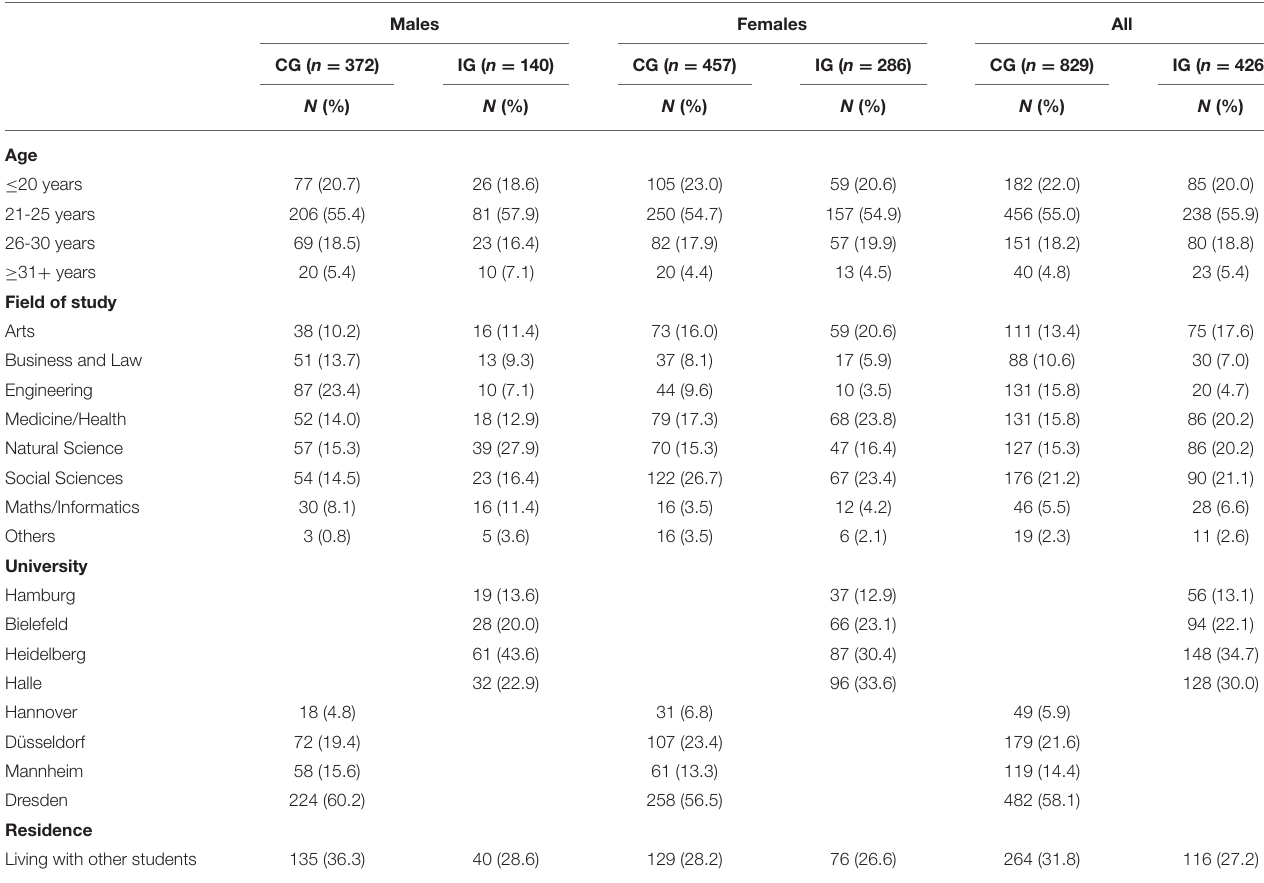
TABLE 1 | Sample characteristics by group and gender at baseline. Males